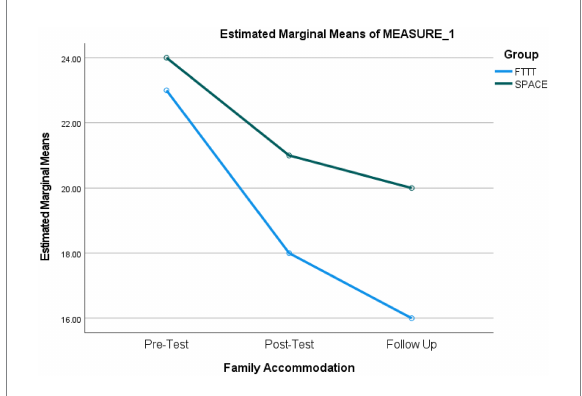
FIGURE 3 Repeated-measures ANOVA revealing significant changes from baseline to follow-up in family accommodation scores.